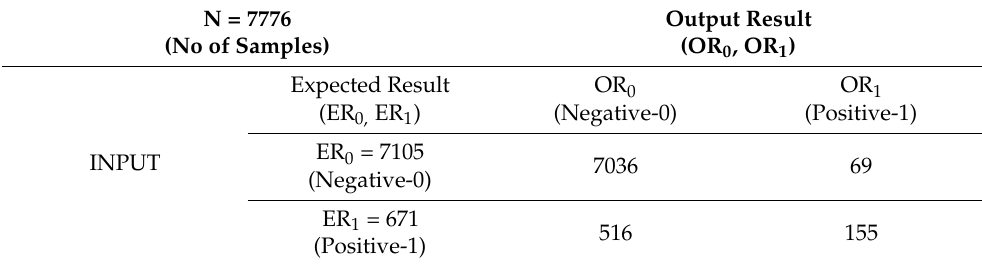
Table 5. DT Testing results.